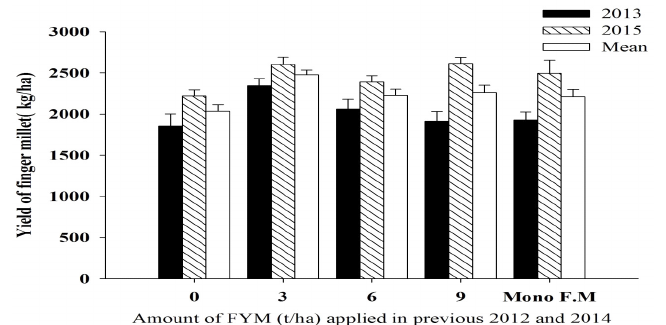
Figure 5. Residual effect of farmyard manure applied to the precursor soybean as the main effect on the yield of subsequent finger millet at Bako, Western Ethiopia. Mono F.M = farmers’ practice, continuous mono-cropping of finger millet with recommended DAP fertilizer.